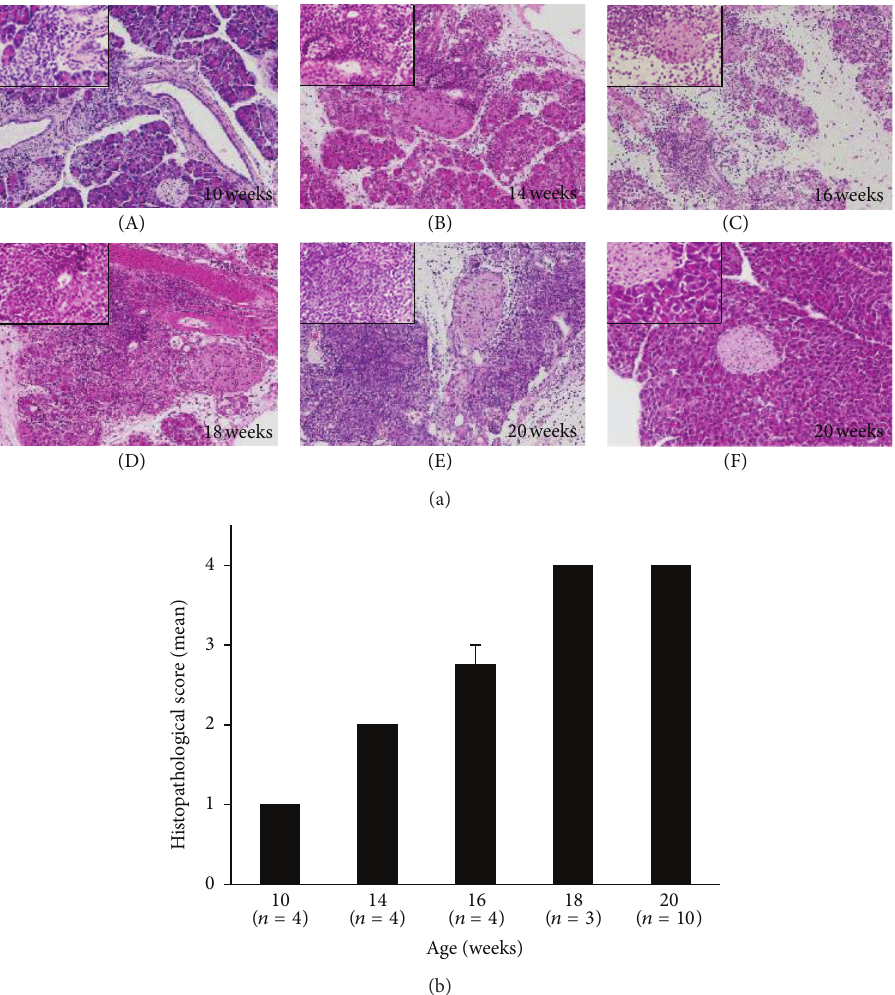
Figure 1: Representative H&E stained histological sections of the pancreases (a) and histopathological scores of the pancreases (b) in poly I:C-treated MRL/Mp mice in the 5 different age groups. The group of 10-week-old mice showed mononuclear cell aggregation and infiltration within the interstitium, and no pancreatic parenchymal destruction (grade 1). The group of 14-week-old mice showed focal parenchymal destruction with mononuclear cell infiltration in the pancreases (grade 2). The group of 16-week-old mice showed diffuse parenchymal destruction, but some parenchymal residue was retained intact in the pancreases (grade 3). The groups of 18- and 20-week-old mice showed that almost all pancreatic tissue, except for the pancreatic islets, was destroyed or replaced with fibrosis or adipose tissue (grade 4). The control mice were no significant change (grade 0). Poly I:C-treated MRL/Mp mice (A)–(E), controls (F). × 100 magnification (large panel), × 400(inset). Data are expressed as mean ±